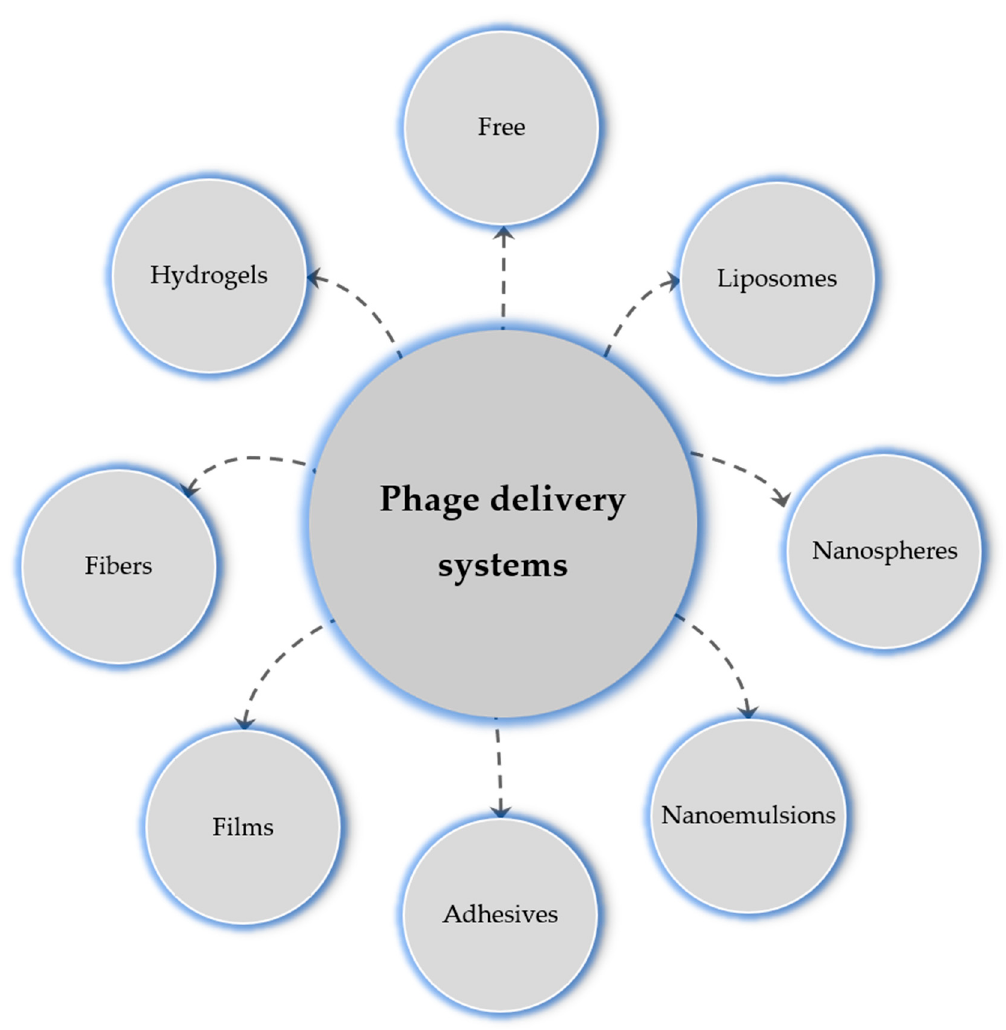
Figure 5. Phage delivery systems to wounds.